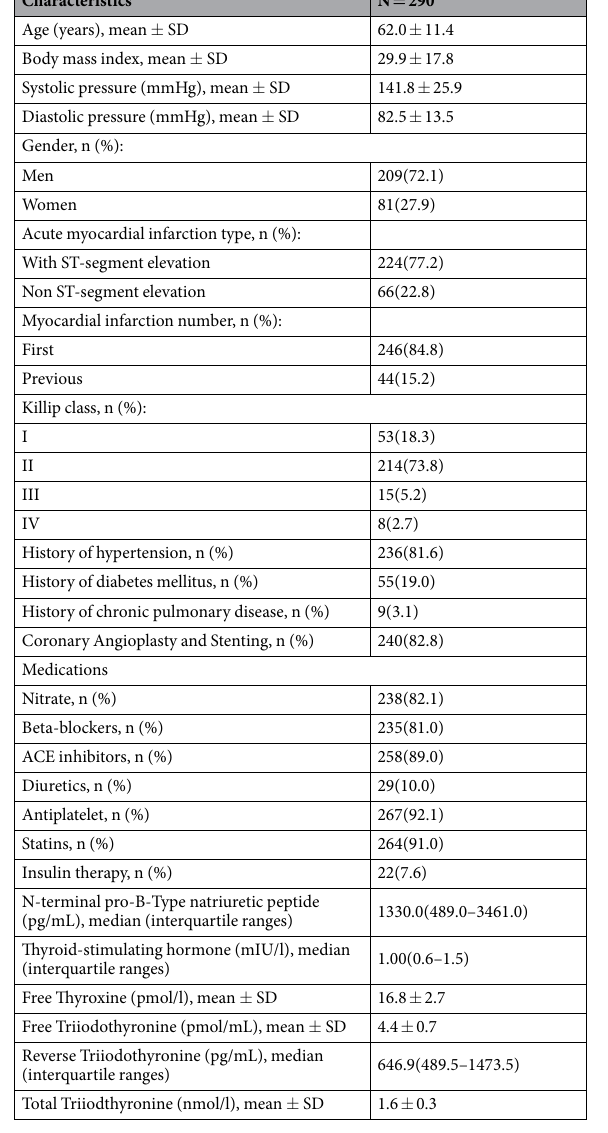
Table 2. Sociodemographic, clinical characteristics and biomarkers of patients with acute myocardial infarction. Values are presented as the mean ± SD, median (interquartile range), or